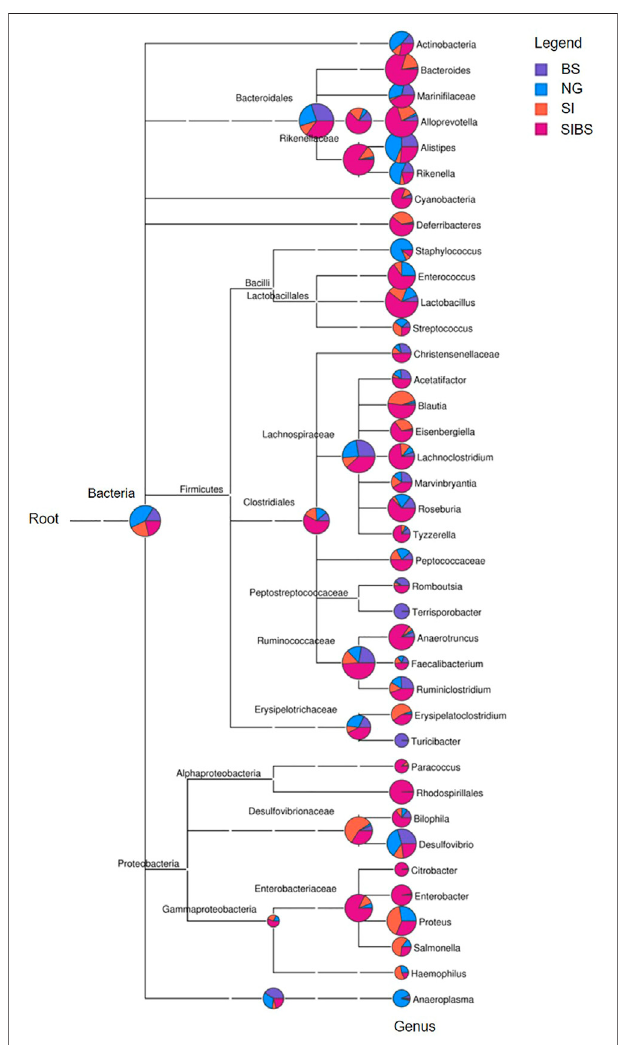
FIGURE 3 | Phylogenetic diversity and taxonomical content of the gut microbiota sequences from all groups computed by MEGAN. In this fi gure, each circle represents a bacterial taxon in the NCBI taxonomy and is labeled by its name. The size of the circle represents the number of reads. NG: normalmicewithPBSgroup.BS:normalmicewithOA B.subtilis group.SI: S. japonicum – infectedmicegroup.SIBS: S.japonicum – infectedmicewithOA B. subtilis